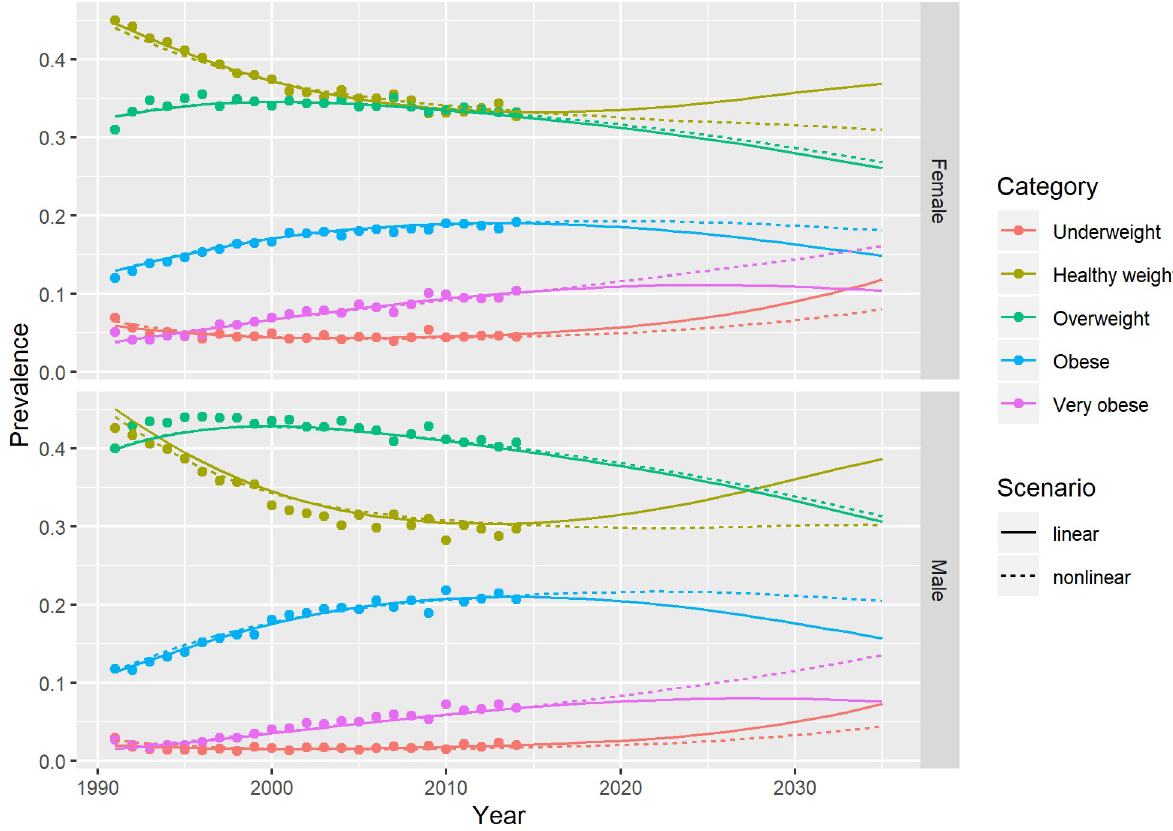
Fig 1. Comparison of linear and non-linear model predictions with data from the Health Survey for